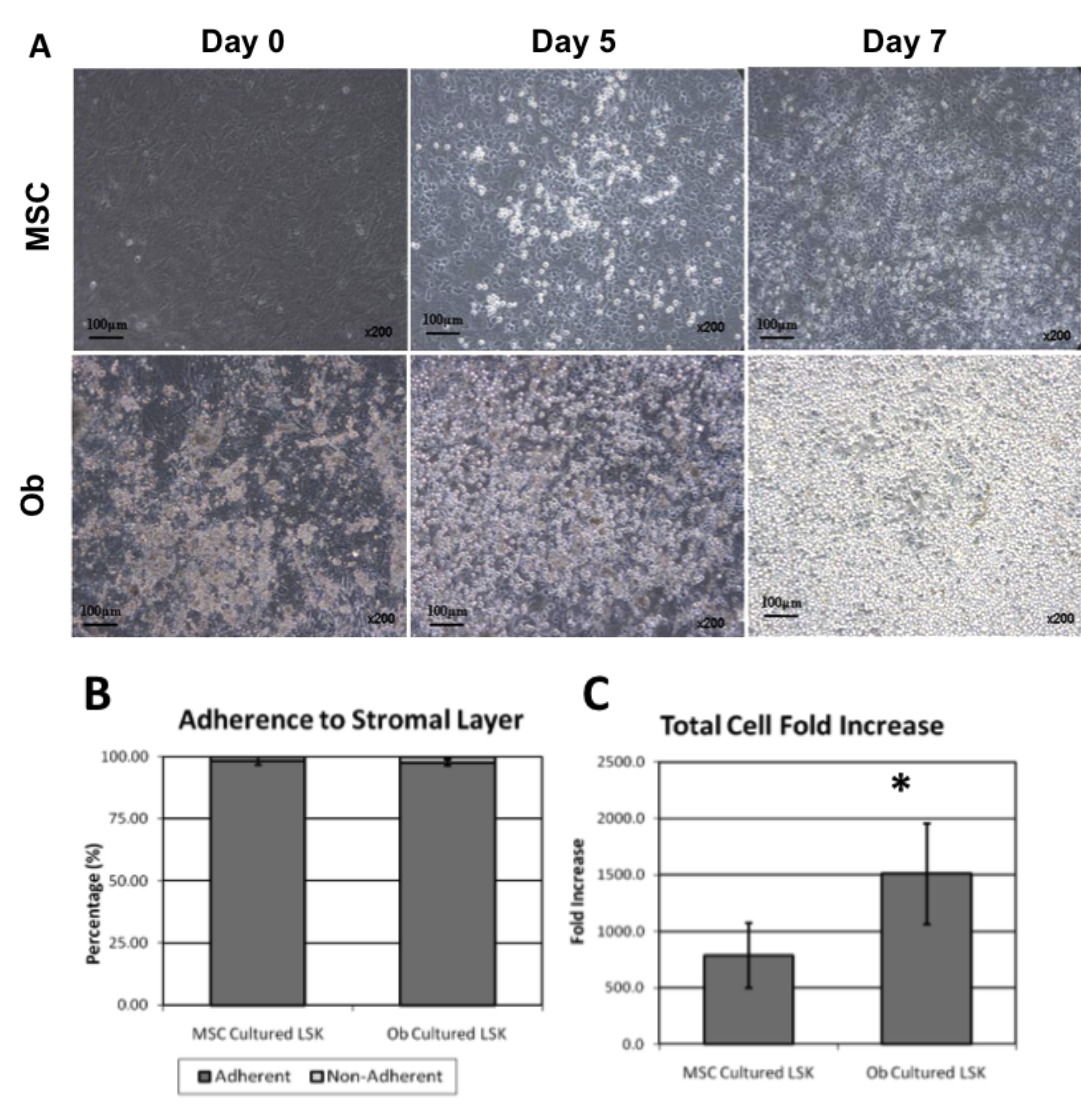
Figure 2. Haematopoietic cell expansion on stromal cell monolayers. ( A ) Co-cultures of HSCs with undifferentiated MSCs or osteoblasts after 0, 5 and 7 days by light microscopy; ( B ) Haematopoietic cells adhered to the stromal layer after the culture was washed ( n = 8); ( C ) Total cell fold expansion after 7 days from the original 1000 LSKs was higher on osteoblast than on undifferentiated MSC monolayers ( p = 0.0013; n = 8); ( D ) Flow cytometry of cultures revealed no differences in LSK proportion on either monolayer ( n = 8); ( E ) Expansion of LSK HSCs, as determined by the product of total expansion and LSK proportion per culture, was significantly higher on osteoblasts compared to undifferentiated MSCs ( p = 0.003; n = 8); ( F ) Myeloid, B cell, T cell and erythroid lineage commitment was similar when cultured on either stromal monolayer ( n = 3). Data is shown as mean ± SD with each point representing independent co-cultures with from individually isolated LSK, MSC and MSC-derived osteoblast cultures from distinct